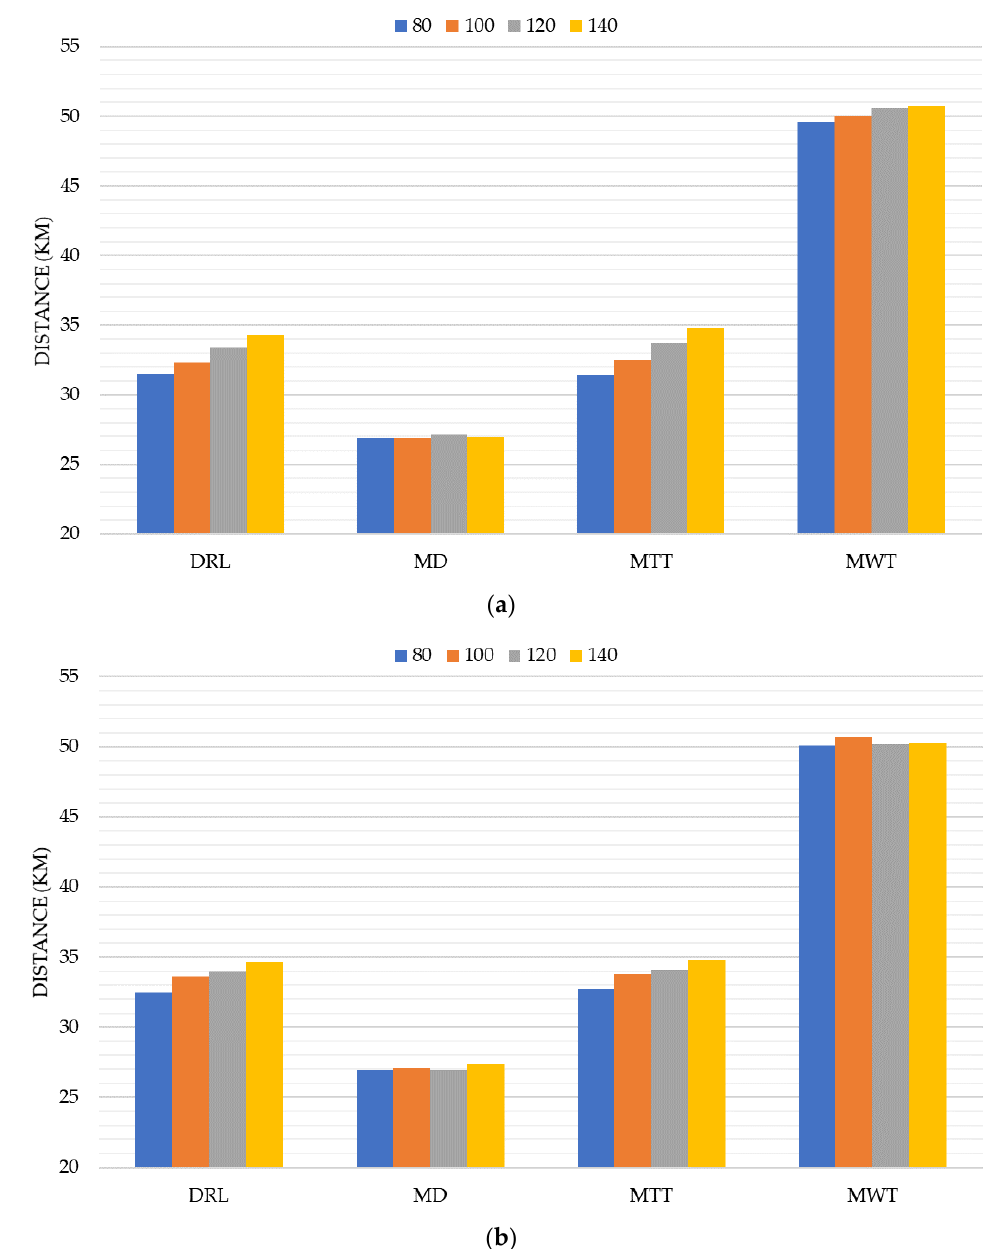
Figure 9. Average travel distance of different number of EVs according to distributions: ( a ) Uniform distribution; ( b ) Normal distribution.